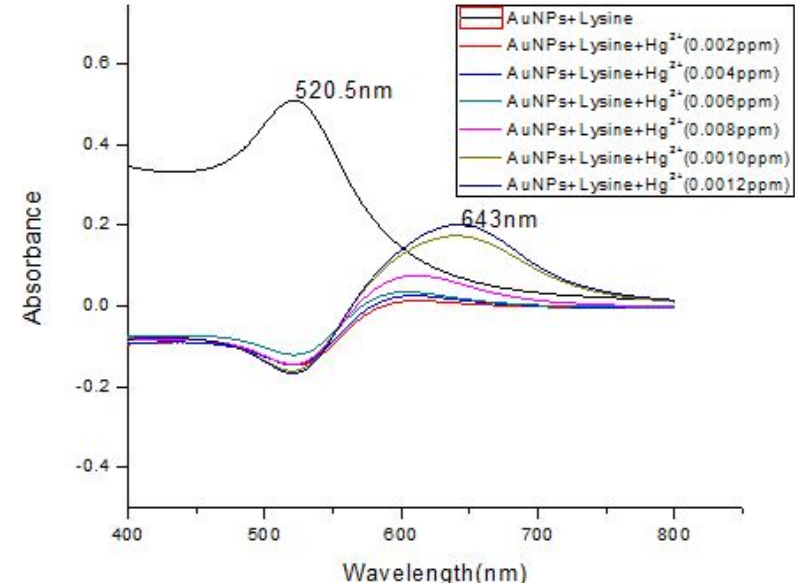
Fig. 3 Spectra for sensing different Hg 2+